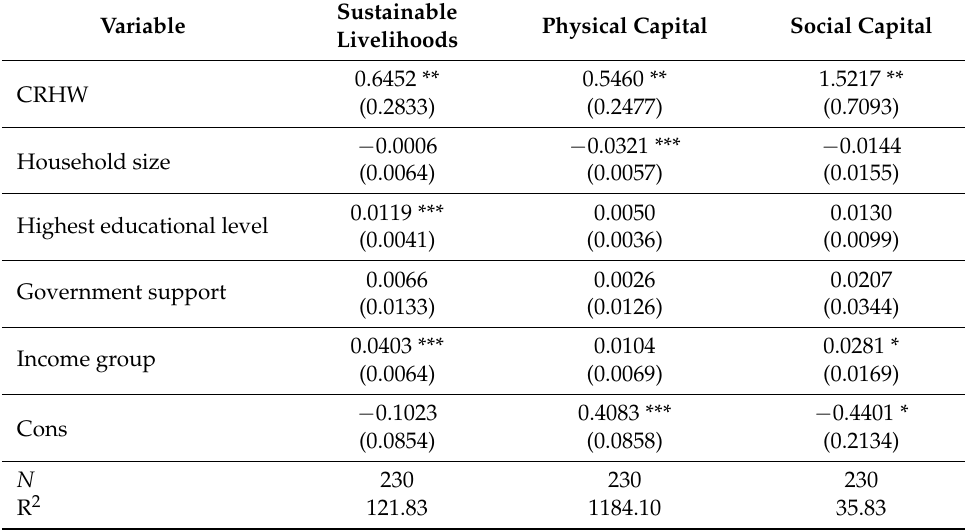
Table 3. Instrumental variable regression analysis: